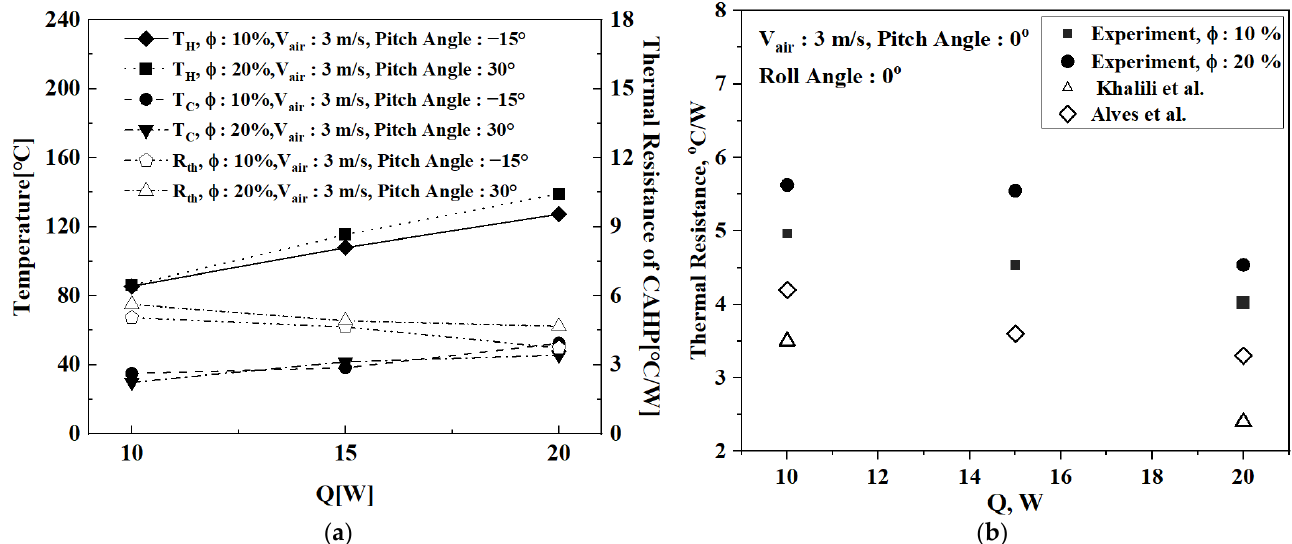
Figure 9. Temperature of the heater and the condenser and the thermal resistance of the CAHP according to Q . ( a ) Experimental characteristics. ( b ) Thermal resistance comparison with results from the